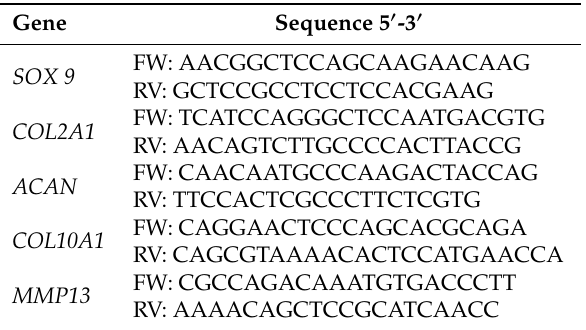
Table 2. Primers used for the qRT-PCR